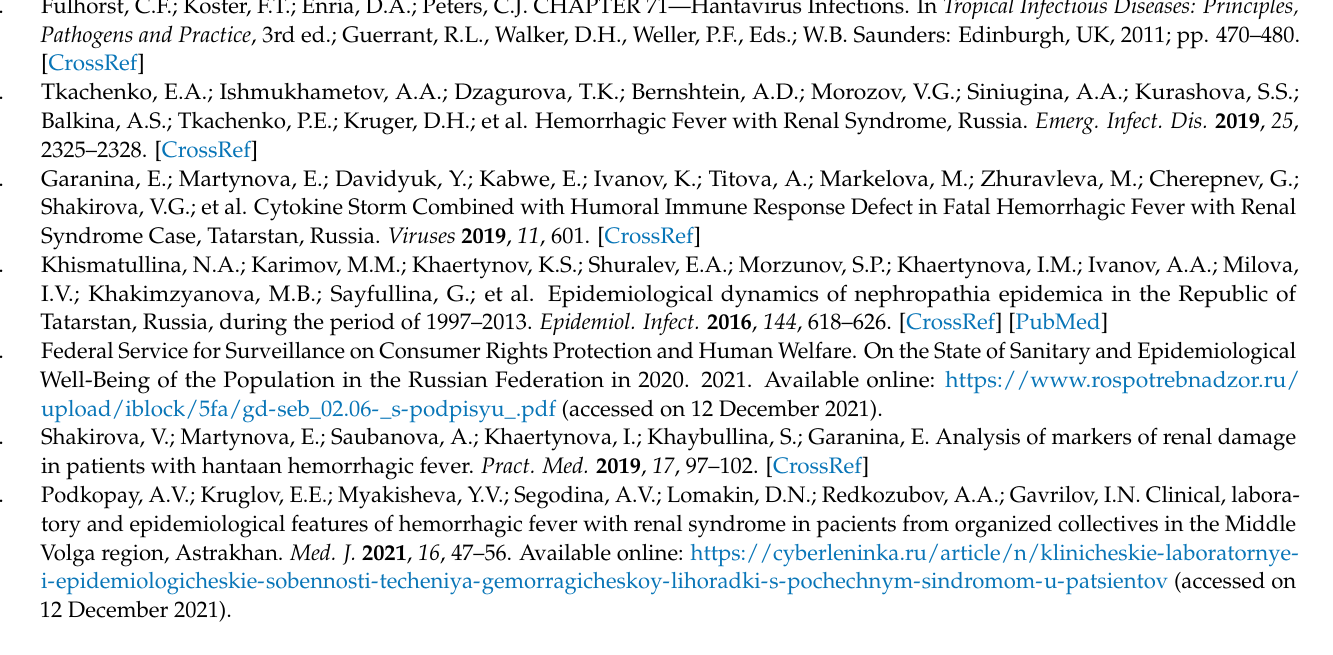
Figure S3. Cytokines and chemokine analysis of MVs cargo. Figure S4: PUUV N proteins in A549 cells after treatment with different concentrations of MVs. Figure S5. Serum cytokine analysis in mice treated with MVs at 14 and 28